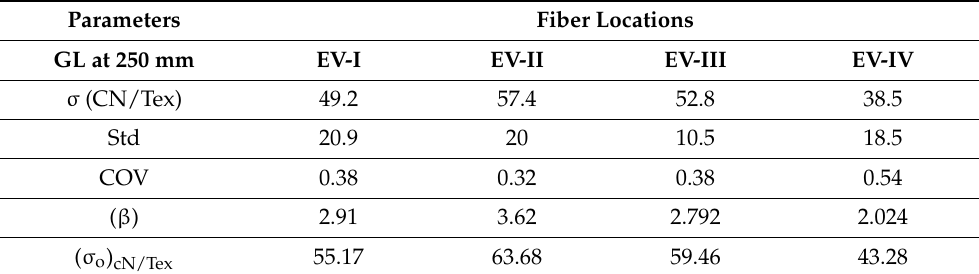
Table 4. Comparison of fiber tenacity (cN/Tex) by Weibull distribution.